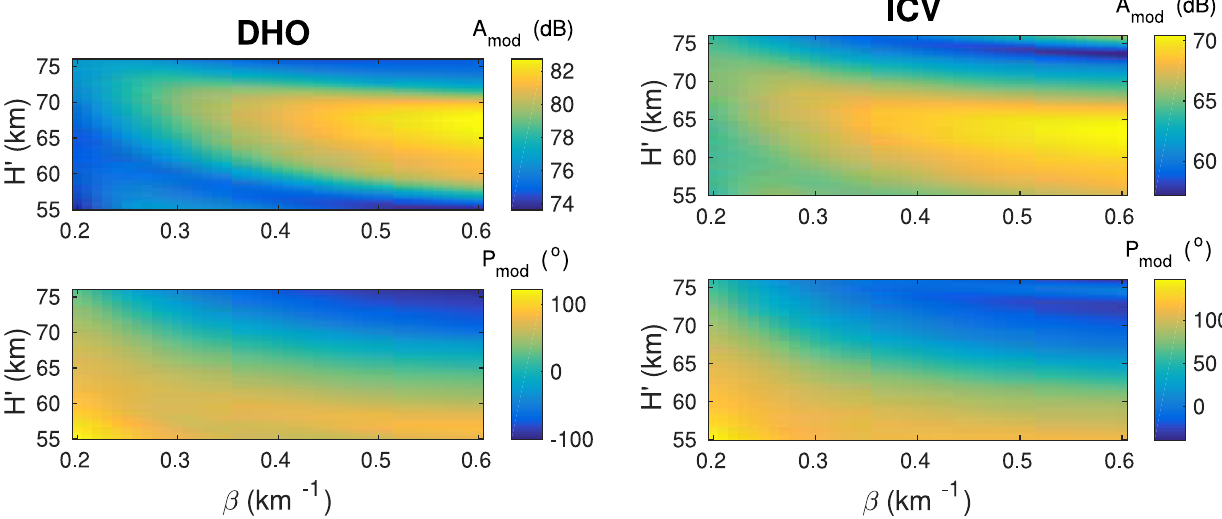
Figure 6. Surface plots of the modeled (by Long-Wave Propagation Capability (LWPC) program) amplitude ( upper panels ) and phase ( lower panels ) of the DHO ( left panels ) and ICV ( right panels ) signal for receiver located in Belgrade, Serbia, as functions of Wait’s parameters β and H (cid:48)